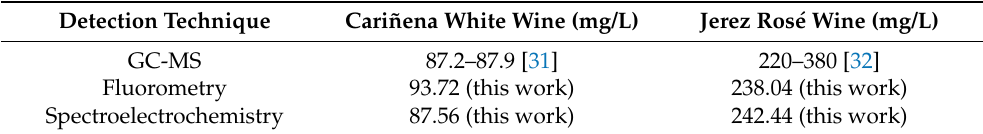
Table 2. Comparison among several methods for the determination of acetaldehyde in Cariñena and Jerez